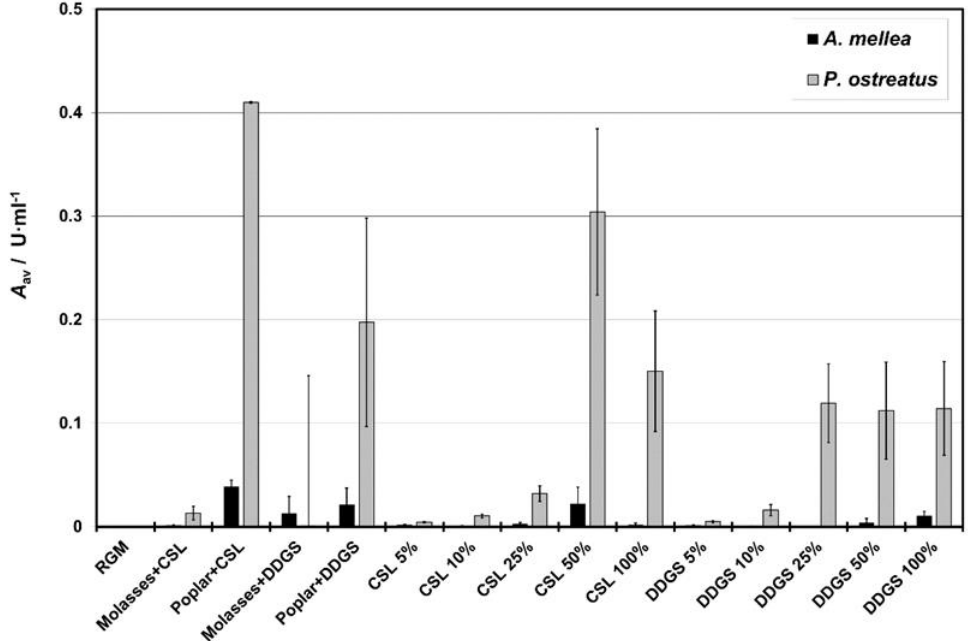
Figure 3. Average laccase activity (A av ) for A. mellea and P. ostreatus measured in different media. Abbreviations: CSL—corn steep liquor; DDGS—dried distillers grains with solubles; RGM—reference growing medium; 100% CSL: CSL with nominal concentration of 5.27% w / v ; 100% DDGS: DDGS with nominal concentration of 7.44% w / v ; 50% CSL or DDGS: CSL or DDGS at 50% of nominal concentration of 100% CSL/DDGS concentration.